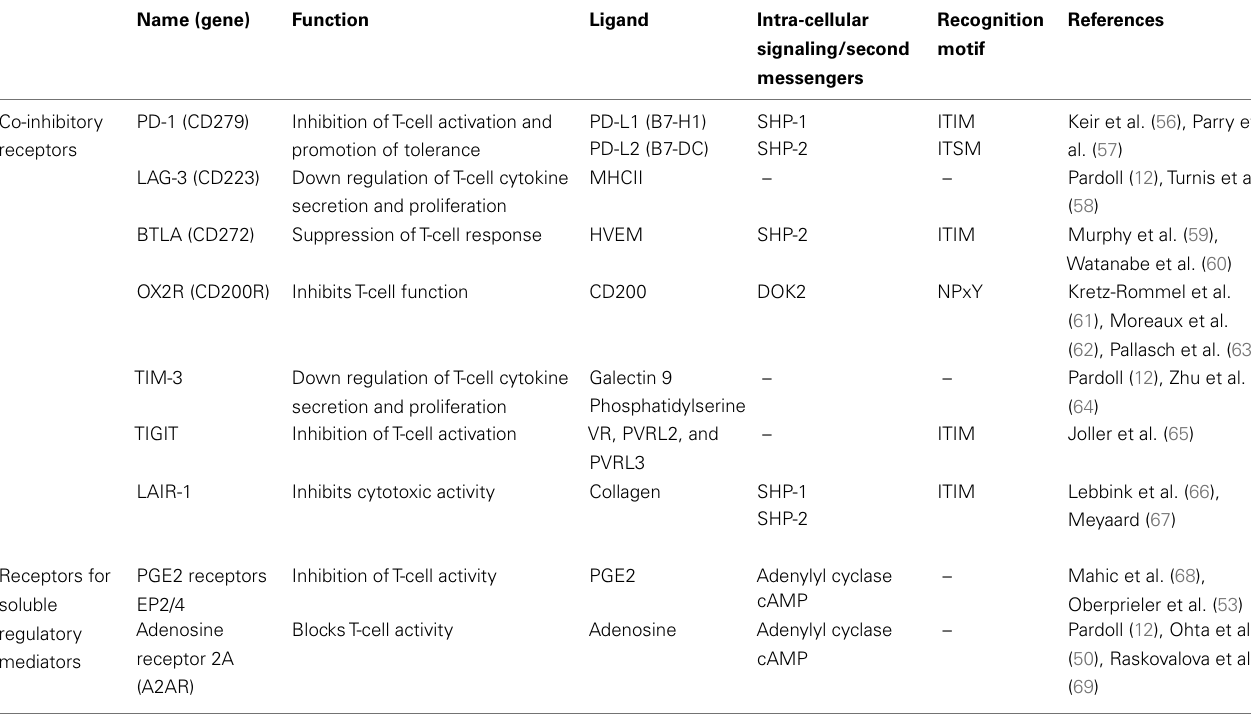
Table 1 | Potential immune checkpoint receptor targets for genome editing in the context of cancer adoptive cellular